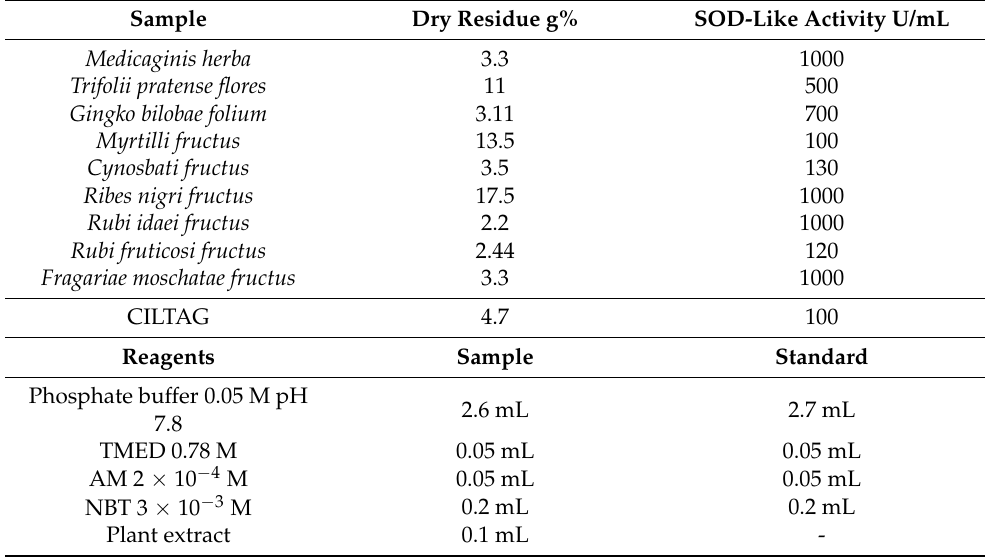
Table 2. The quantities of ingredients and reagents.